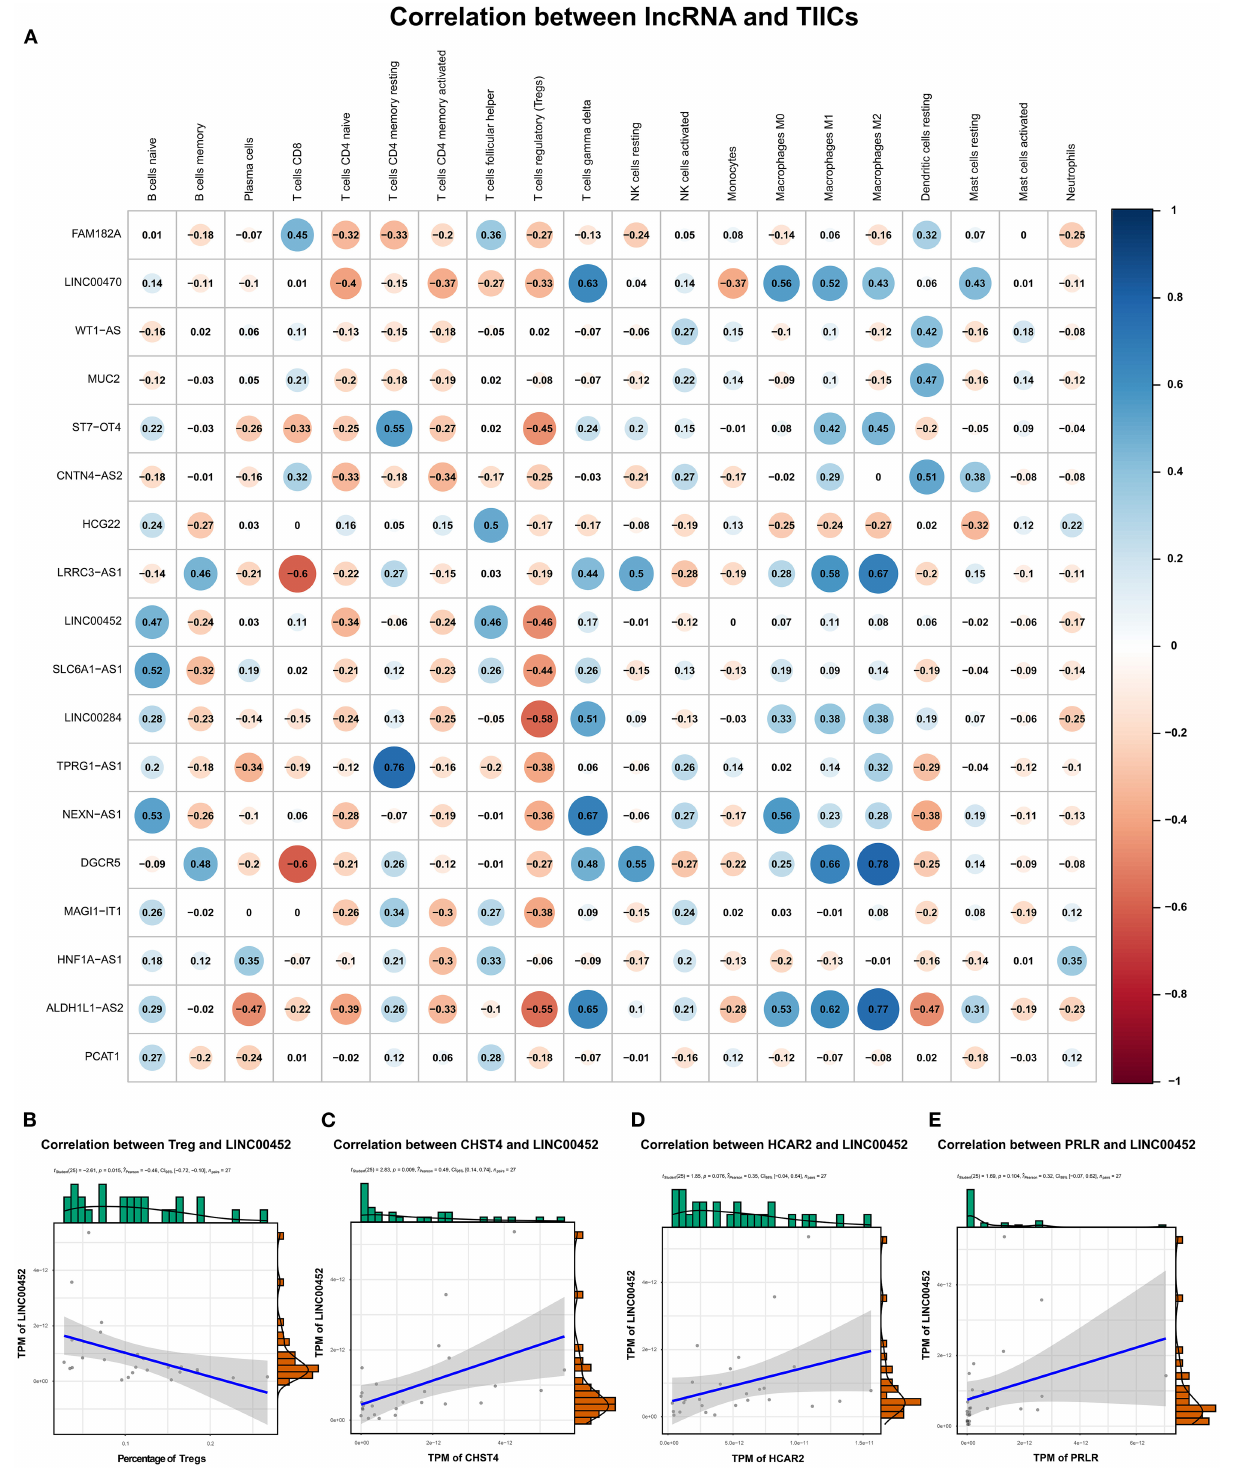
Frontiers in Neurology |